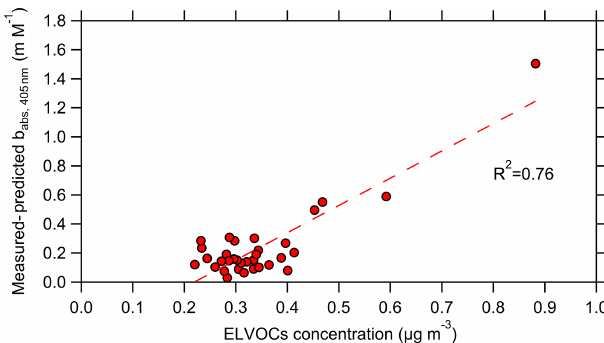
Figure 7. The difference between the measured and the predicted unexplained b abs , 405 as a function of the estimated concentration of the ELVOCs. The data shown represent 3h averaged